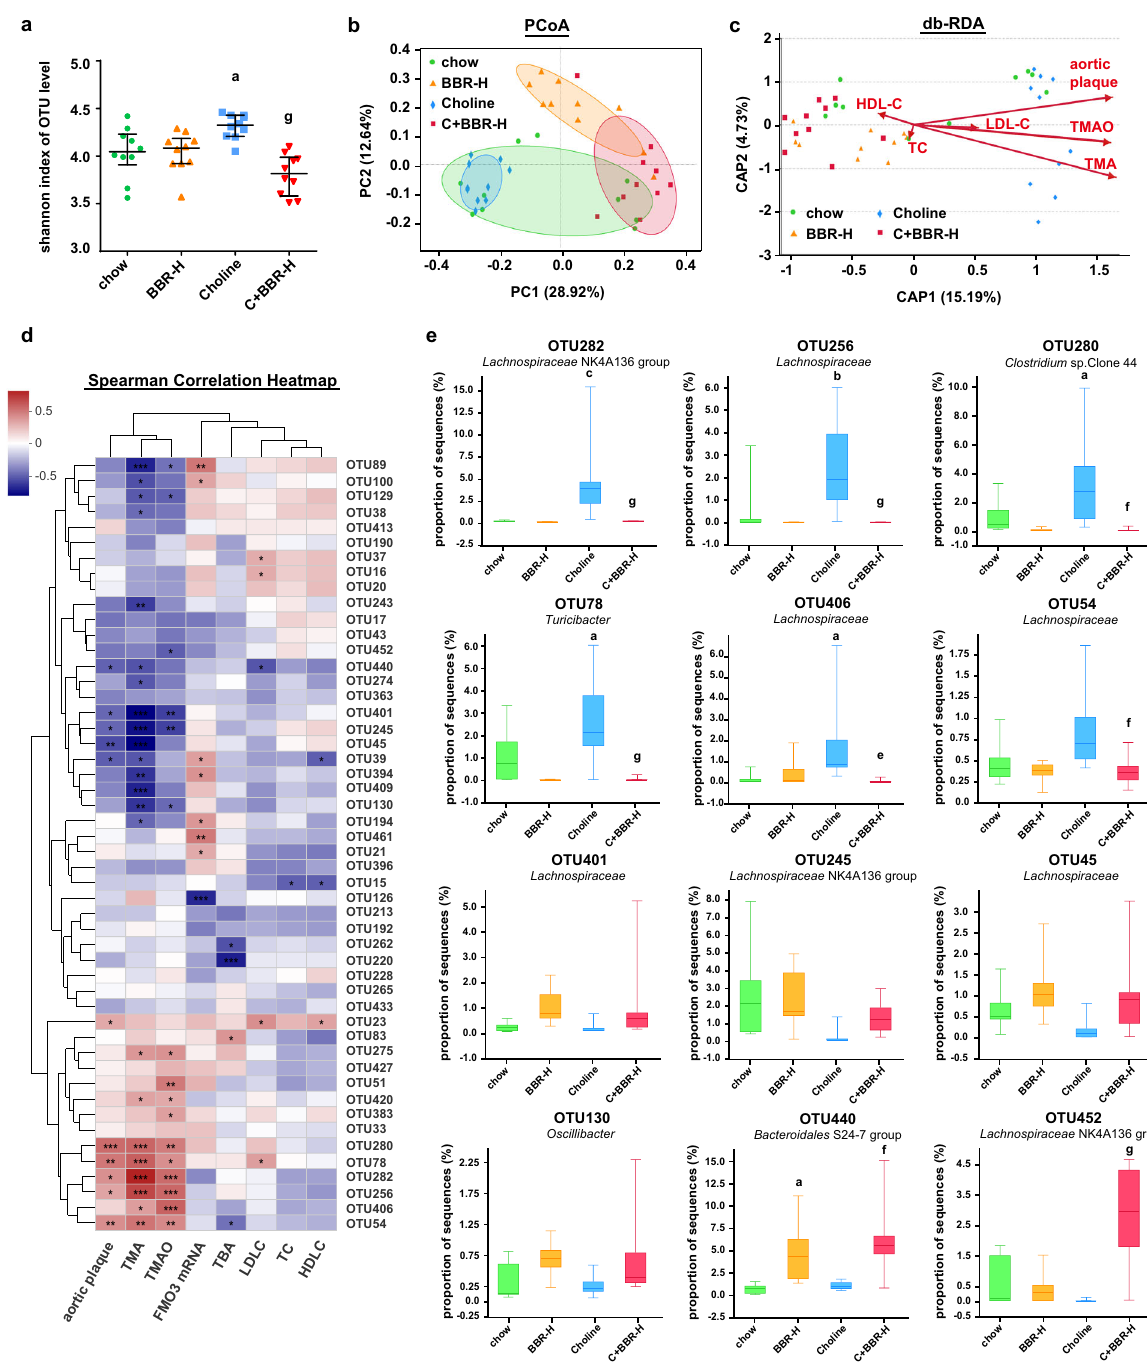
Fig. 4 BBR inhibited TMA and TMAO production via remodeling gut microbiota in ApoE KO mice. Cecal content samples were collected from female ApoE KO mice which were fed a chow or choline diet for 4 months with or without BBR ( n = 10 for each group), and 16S rRNA gene was ampli fi ed and sequenced. a Microbiota alpha diversity was measured using the Shannon index based on OTU level. Error bars were median with interquartile ranges, and p values were from Kruskal – Wallis H test. b PCoA analysis of bray curtis distance was analysis based on OTU level for microbiota beta diversity (ANOSIM R = 0.5659, p = 0.001). c Distance-based RDA showed the correlation between key microbiota phylotypes at OTU level and phenotypes (red arrows) including TMA (correlation coef fi cient r 2 = 0.548, p = 0.001), TMAO ( r 2 = 0.3477, p = 0.001), aortic plaque area ( r 2 = 0.3477, p = 0.001), TC ( r 2 = 0.0132, p = 0.773), LDL-C ( r 2 = 0.0353, p = 0.502), and HDL-C ( r 2 = 0.0202, p = 0.705) within four groups based on the bray curtis algorithm. d Spearman correlation heat map demonstrated the correlation between key microbiota phylotypes and phenotypes (TMA, TMAO, aortic plaque area, TC, LDL-C, HDL-C, TBA and FMO3 mRNA) at the OTU level. The top 50 dominant OTU in all samples were selected to construct a heat map. Red denotes a positive association, blue a negative association, and white no association. * p <0.05; ** p < 0.01; *** p < 0.001. The annotations of the taxonomy of OTUs are in Supplementary Table 1. e The abundance of signi fi cant different OTUs designated in Fig. 4d among four groups. Boxes show the median with interquartile ranges ( n = 10 for each group), whisker shows the minimum and maximum values. p values were from Kruskal – Wallis H . a p < 0.05; b p <0.01; c p <0.001 (versus chow-diet group); e p < 0.05; f p <0.01; g p <0.001 (versus choline-diet